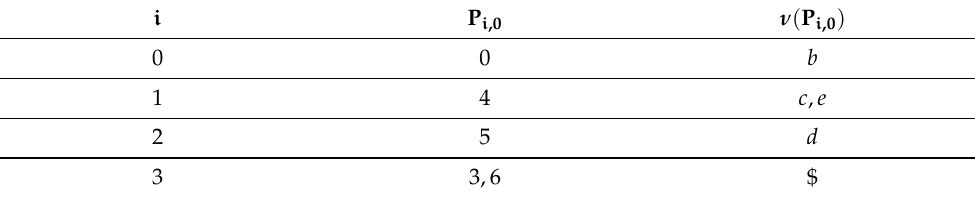
Table 2. The sets of states P i ,0 and the valid lookahead sets ν p P i ,0 q for the specification Ξ in (3). i P i ,0 ν p P i ,0 q 0 0 b 1 4 c , e 2 5 d 3 3,6